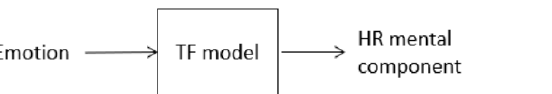
Figure 3. Single-input single-output (SISO) TF model to be identified in the data-based mechanistic modelling.